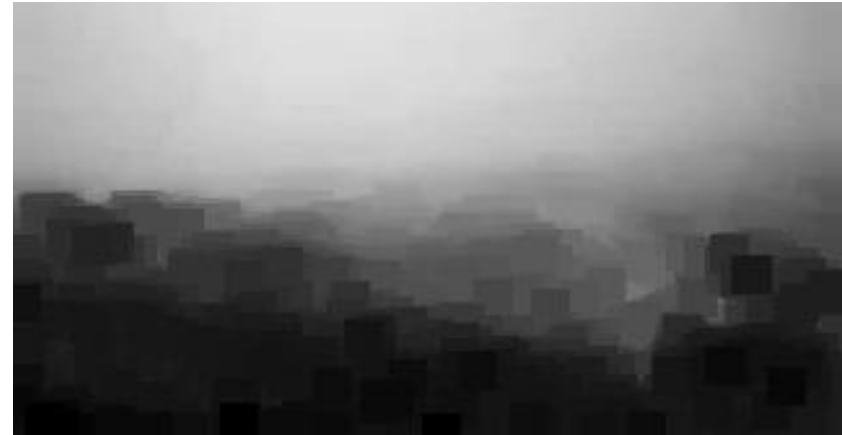
Figure 10. Low-intensity visualization result.